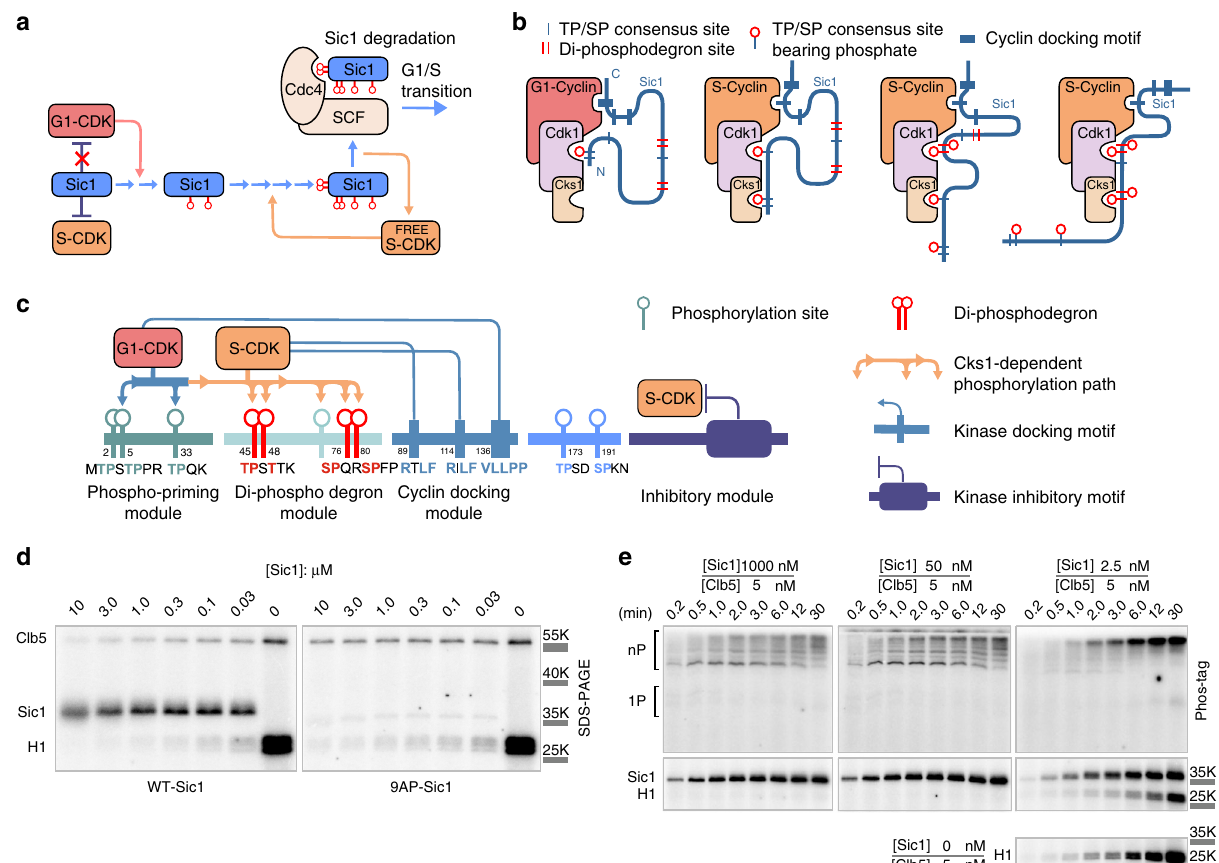
Fig. 1 Processive phosphorylation of Sic1 within the S-CDK – Sic1 inhibitory complex. a A model for G1/S transition switch in S. cerevisiae . The S-CDK inhibitor Sic1 fi rst undergoes priming phosphorylation by G1-CDK, followed by phosphorylation of the degrons by a small fraction of uninhibited S-CDK, directing Sic1 to Cdc4-SCF-mediated ubiquitination and proteolysis. Further release of free S-CDK accelerates Sic1 degradation. b The general dynamics of sequential phosphorylation of Sic1 by cyclin – Cdk1 – Cks1 complexes. The disordered N-terminal non-inhibitory fragment (amino acids 1 – 215) is shown